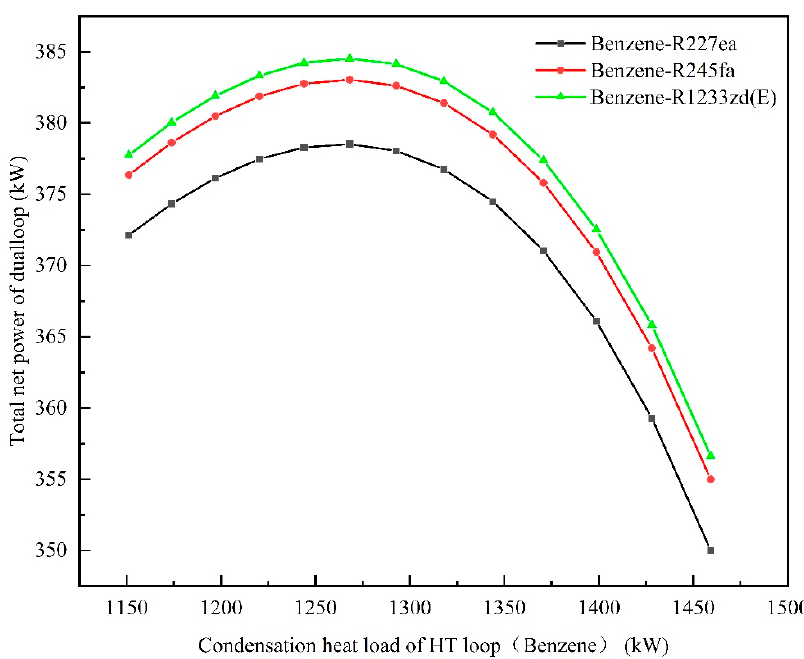
Figure 14. Net power of the LT loop with benzene as the HT loop’s working fluid.